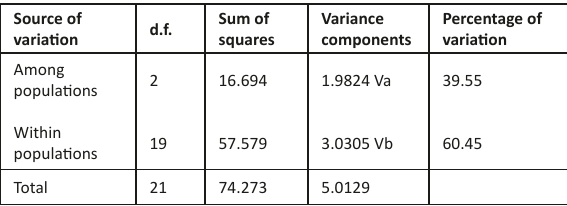
Table 4. Overall and pairwise F values Table 5. Analysis of Molecular Variance (AMOVA) within and ST Groups compared